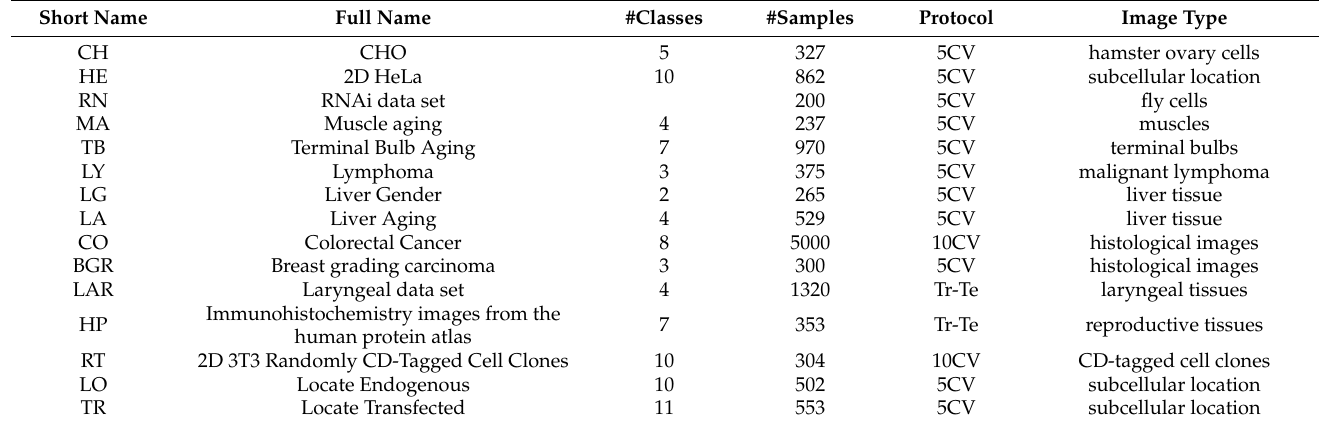
Table 3. Description of the data sets: xCV means a x fold cross-validation; Tr-Te means that training and test set are split by the authors of that data